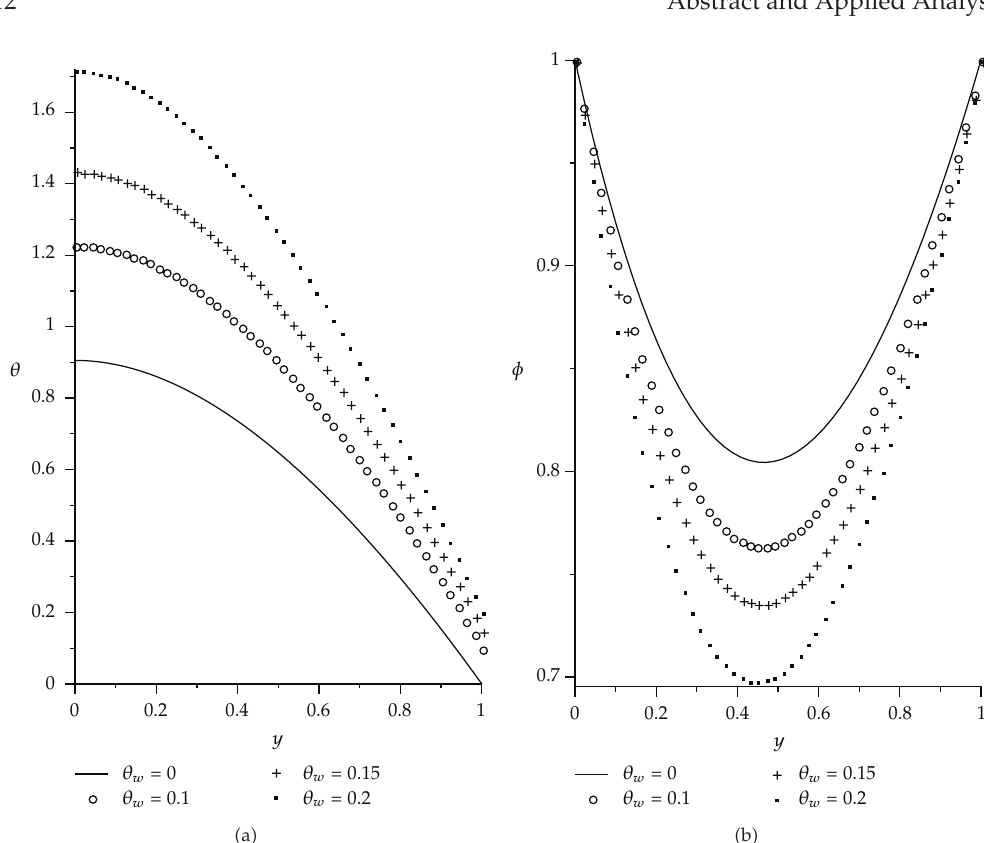
Figure 9: Temperature and oxygen concentration profiles for m (cid:8) 0 . 5 , n (cid:8) λ (cid:8) β (cid:8) 1 , ε (cid:8) 0 .